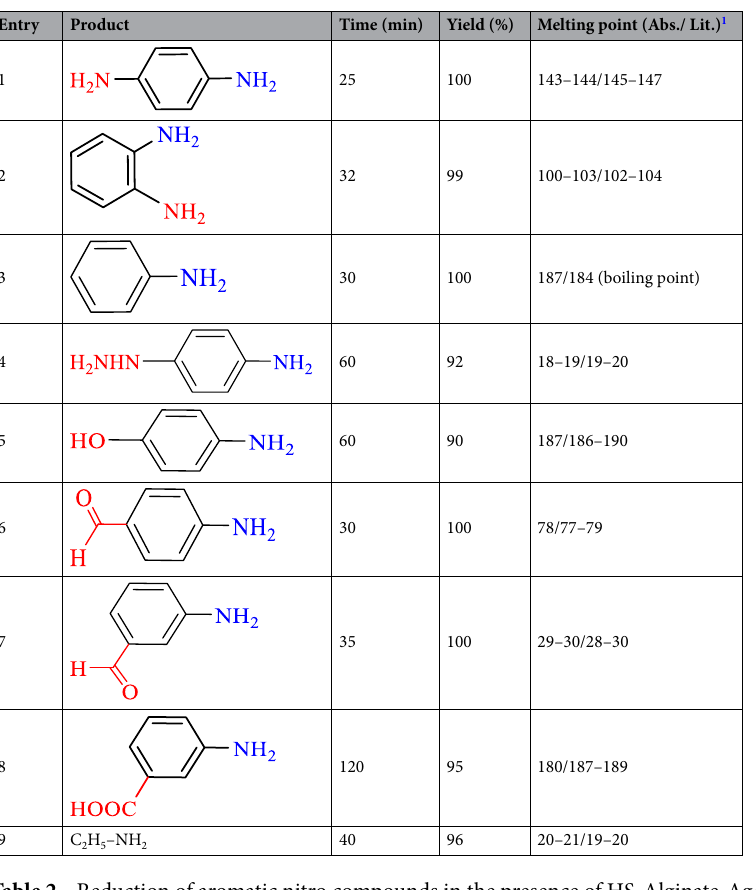
Table 2. Reduction of aromatic nitro compounds in the presence of HS-Alginate-Ag/Fe 3 O 4 and NaBH 4